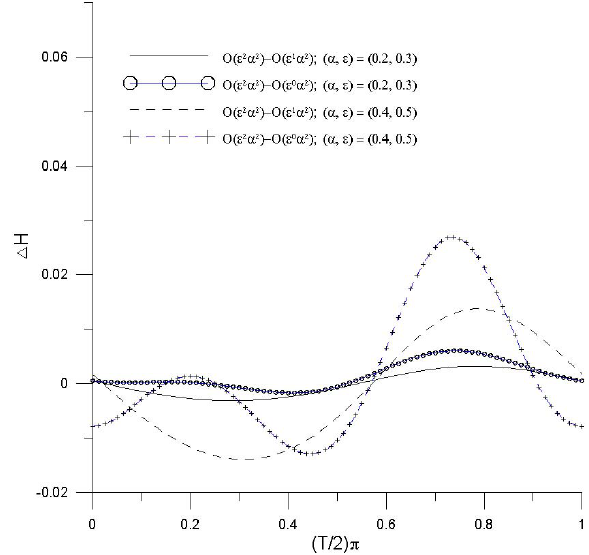
Fig. 5b. Difference between second-order ε , first-order ε and zero- order ε for order α 2 when ( α , ε )=(0.2, 0.3) and ( α , ε )=(0.4,